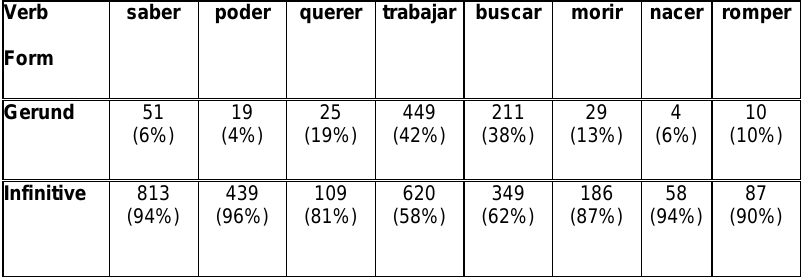
Table 4: The distribution (raw numbers and percentages) of non-finite forms for the verbs